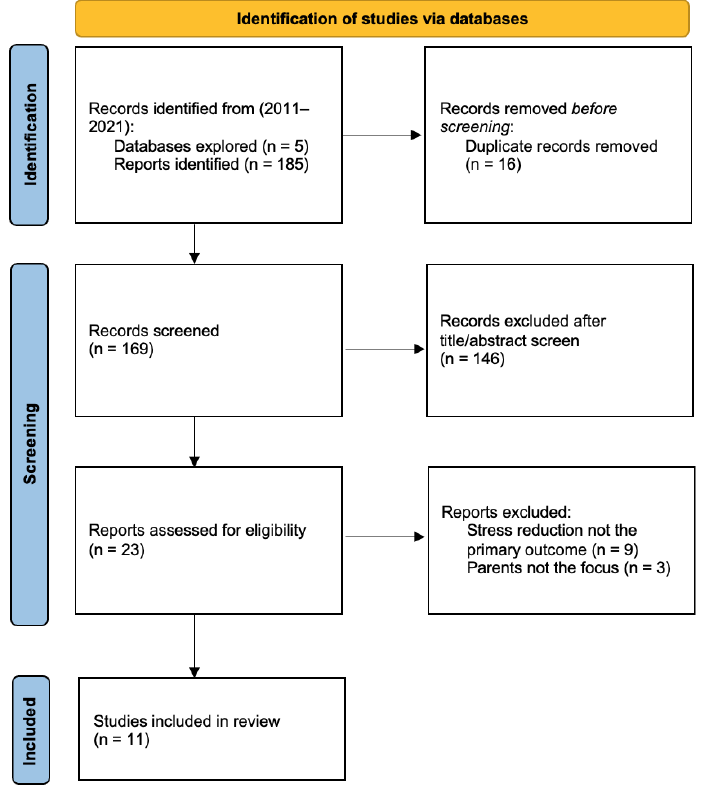
Figure 1. PRISMA Flow Diagram.